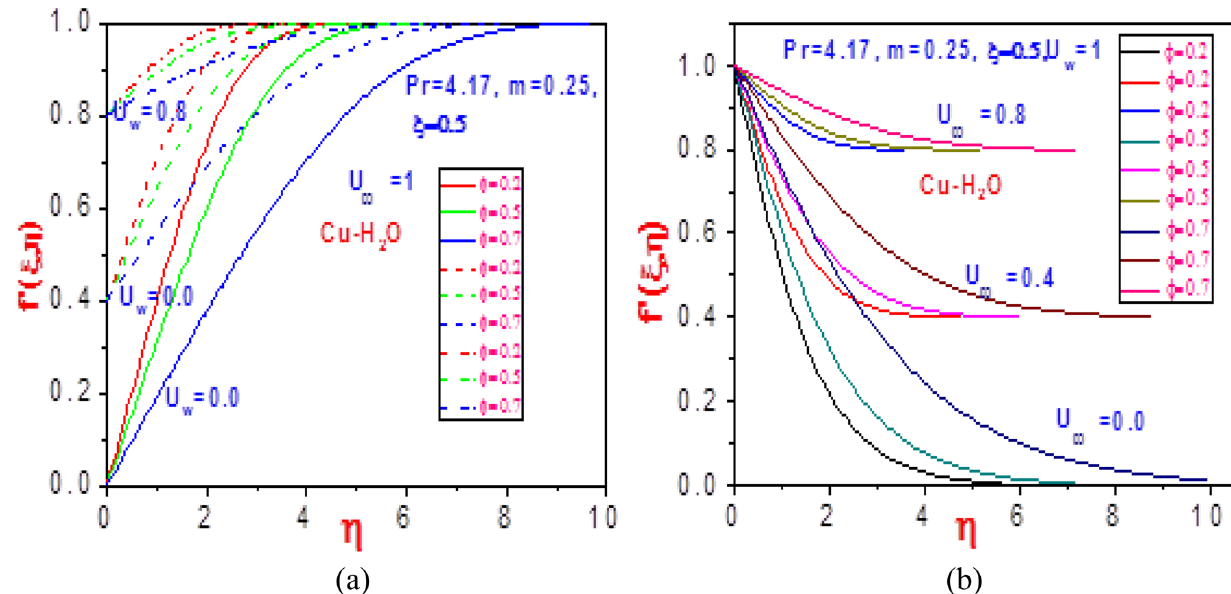
Figure 2. Profiles of velocity f ′ (ξ , η) for ( a ) different values of U ∞ with U w = 1 and ( b ) different values of U w with U ∞ = 1